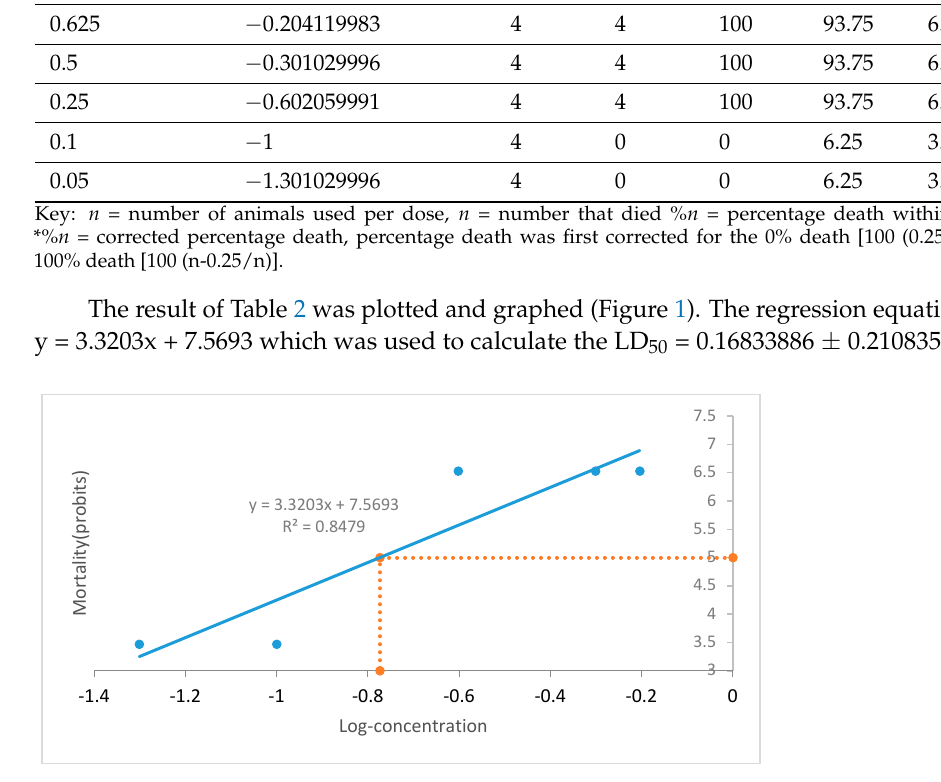
Figure 1. Log 10 of concentrations of Naja melanoleuca venom against the mortality of rats.